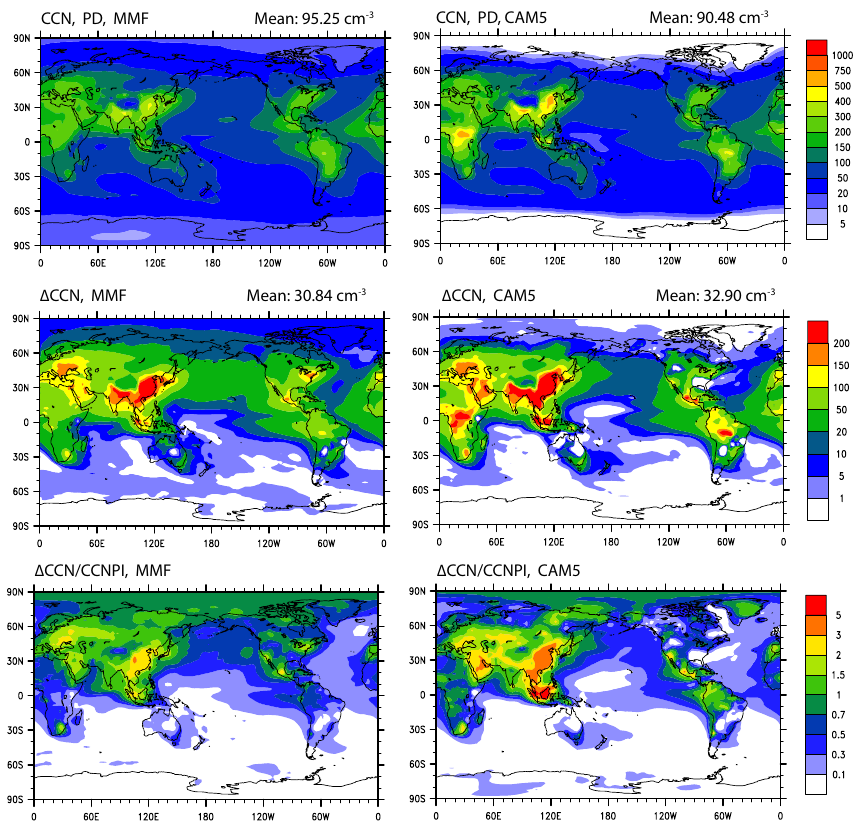
Fig. 9. Annual-averaged global distribution of CCN concentrations at 0.1% supersaturation averaged over the lowest 8 model levels (surface to about 800hPa) in the PD simulations (top panels), the difference between PD and PI (PD-PI) (middle panels), and the relative differences between PD and PI [(PD-PI)/PI] (bottom panels) in both the MMF (left panels) and CAM5 (right panels).